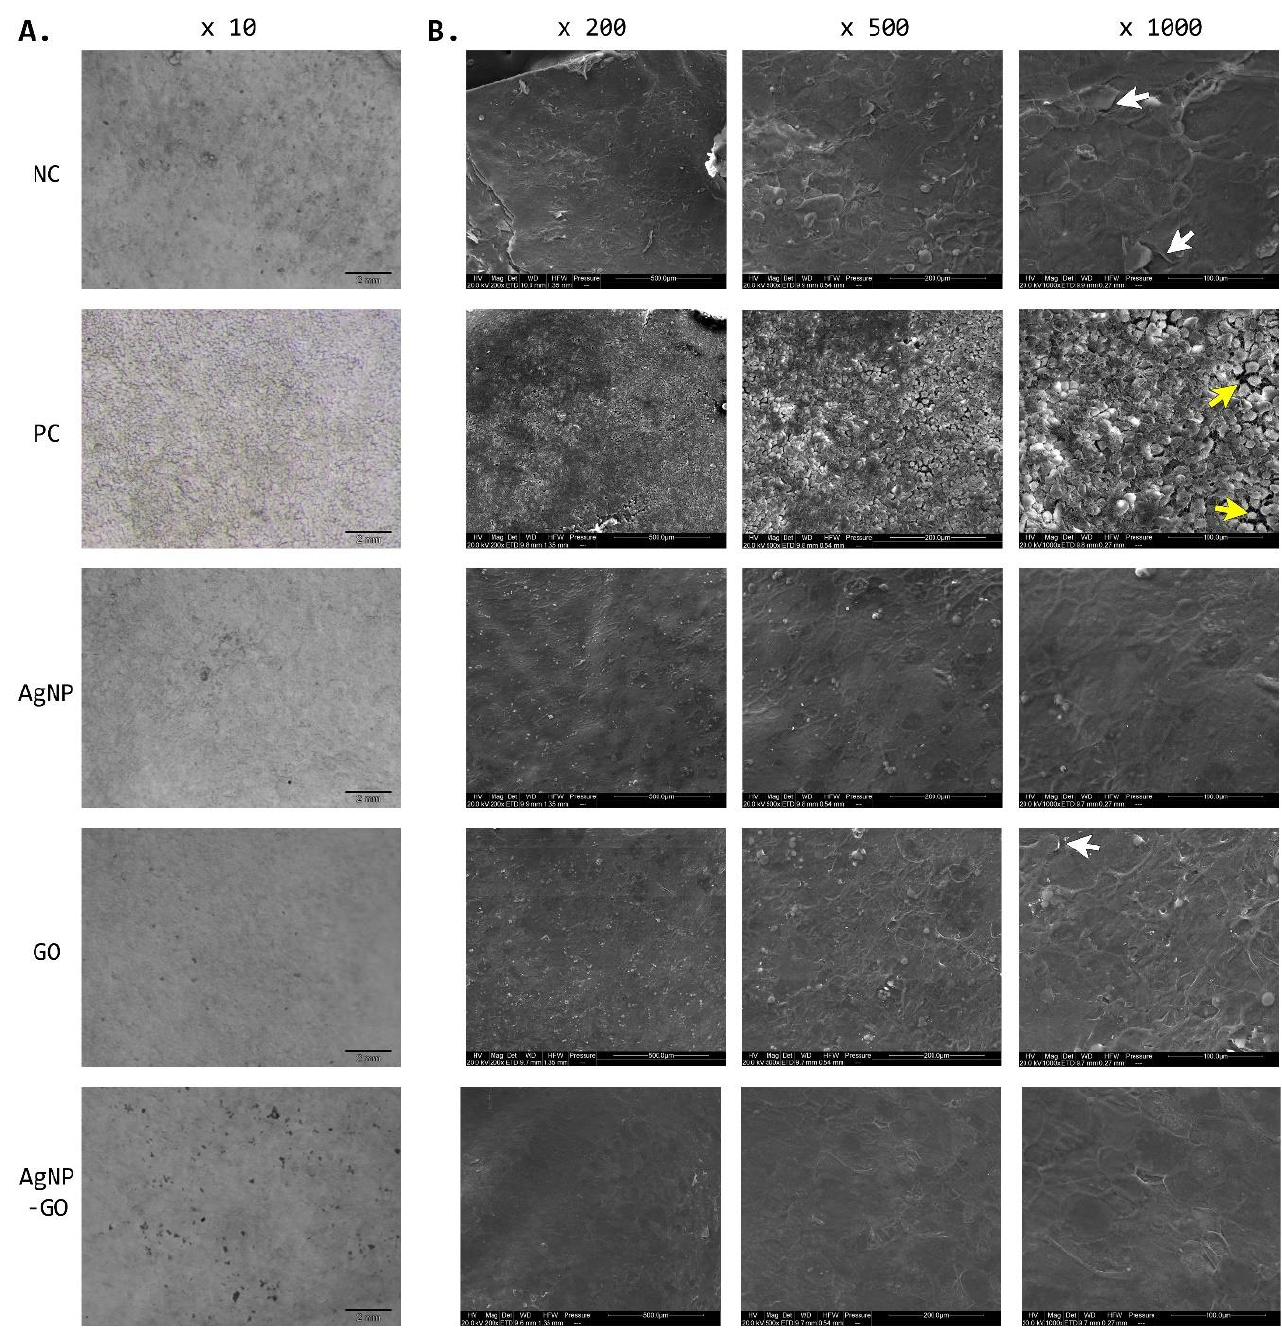
Figure 4. Visualization of EpiDerm™ surface 24 h after treatment. Comparison of silver nanoparticles (AgNP), graphene oxide (GO), and AgNP-GO complex activity to the negative control (NC, DPBS) and positive control (PC, SDS). ( A ) Digital photos of EpiDerm™ without fixation were obtained using a stereo microscope. ( B ) Tissues imaged in a scanning electron microscope were fixed in 2.5% l-glutaraldehyde in PBS. White arrows indicate the places of exfoliation and keratinization of the top layer; yellow arrows indicate a disruption of the continuity of the tissue surface.